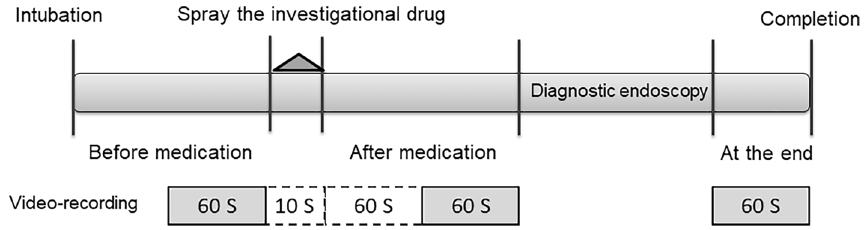
Figure 1. Schematic diagram of gastric peristalsis evaluation. Video images were recorded for three time periods: before medication (for 60 s), after medication (from 60 to 120 s after spraying the investigational drug), and at the end of esophagogastroduodenoscopy (for 60 s). The onset time of antiperistaltic effect was evaluated from 0 to 60 s after spraying the investigational